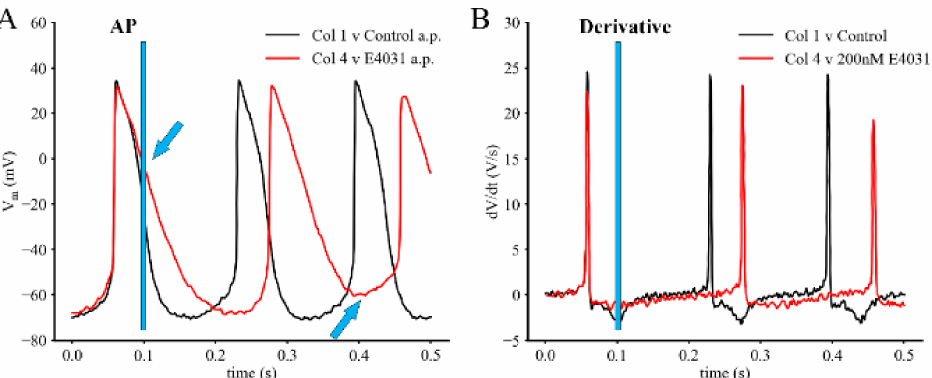
Figure 1. Effects of E4031 on the Action Potential and Pacemaker Depolarization in Adult Mouse Sino Atrial Node (SAN) Primary Pacemaker Myocytes. The traces in Panel ( A ) show three superimposed spontaneous action potentials and pacemaker depolarizations under control conditions (black) and after the application of 200 nM E4031 (red). The vertical blue line denotes the slowing of repolarization and broadening of the action potential duration. The blue arrow at 0 mV marks this effect and the second blue arrow at − 60 mV denotes the E4031-induced depolarization of the maximum diastolic potential. E4031 is a quite selective blocker of the HERG K + current. The superimposed traces in Panel ( A ) consist of two sets of superimposed action potentials; and in Panel ( B ) the corresponding first derivative records are shown. Note from the red traces that E4031 markedly reduces the rate of depolarization and repolarization of the action